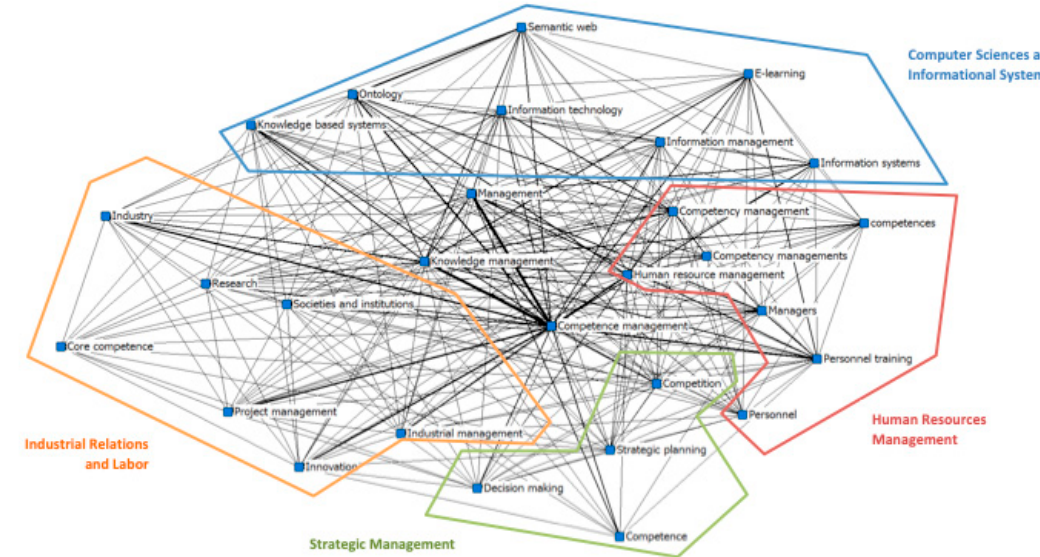
Figure 2. Macro-categories that characterize competence-based management.